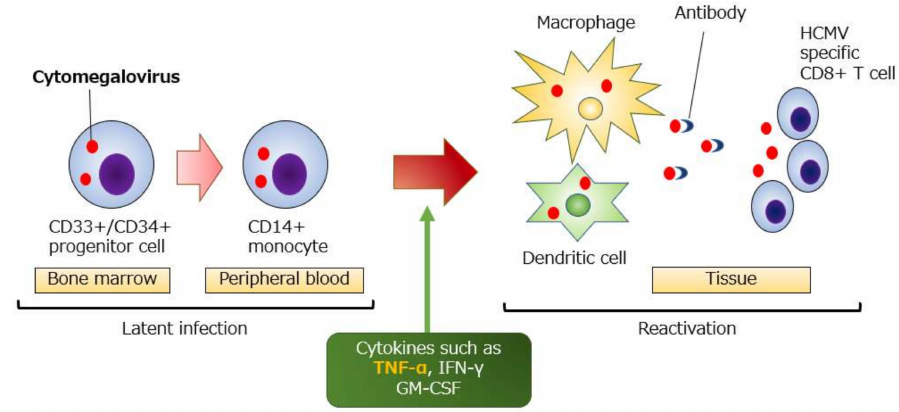
Figure 1. Latent infection and reactivation of human cytomegalovirus (HCMV). HCMV latently infects the CD33 +/ CD34 + cells in the bone marrow and the di ff erentiated CD14 + monocytes in the peripheral blood. HCMV reactivation occurs when HCMV-infected cells enter the tissue and di ff erentiate into macrophages or dendritic cells. Locally-reactivated HCMV infection is prevented from spreading to the whole body by anti -HCMV antibodies and CD8 + T cells. TNF- α : tumor necrosis